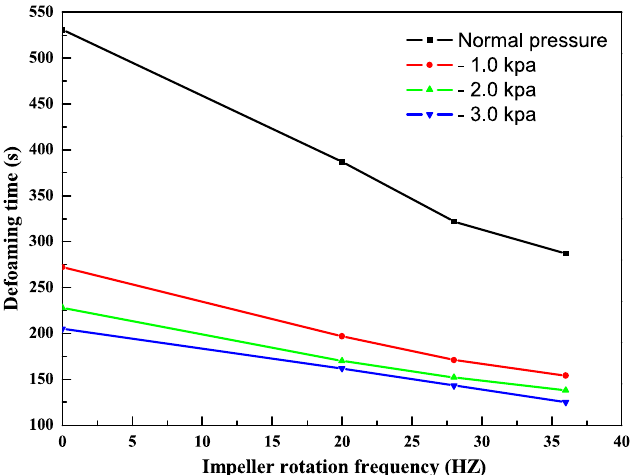
Figure 7. Relationship between impeller rotation frequency and defoaming time when using SC